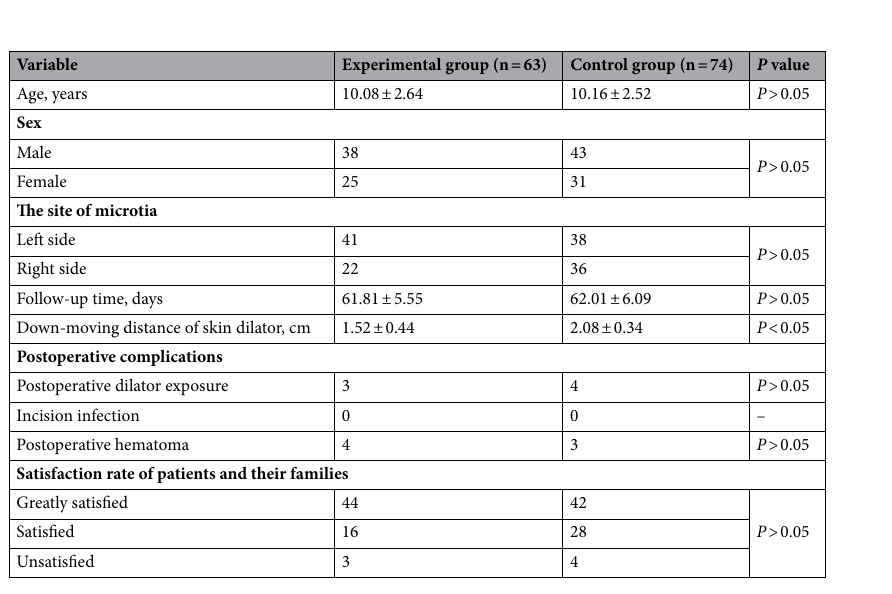
Figure 4. Typical patients in the experimental group. ( a ) Front view of typical patient 1 in the experimental group. ( b ) Lateral view of typical patient 1 in the experimental group. ( c ) Front view of typical patient 2 in the experimental group. ( d ) Lateral view of typical patient 2 in the experimental group. The red reference line is the horizontal line of the lowest point of the earlobe of the malformed ear.